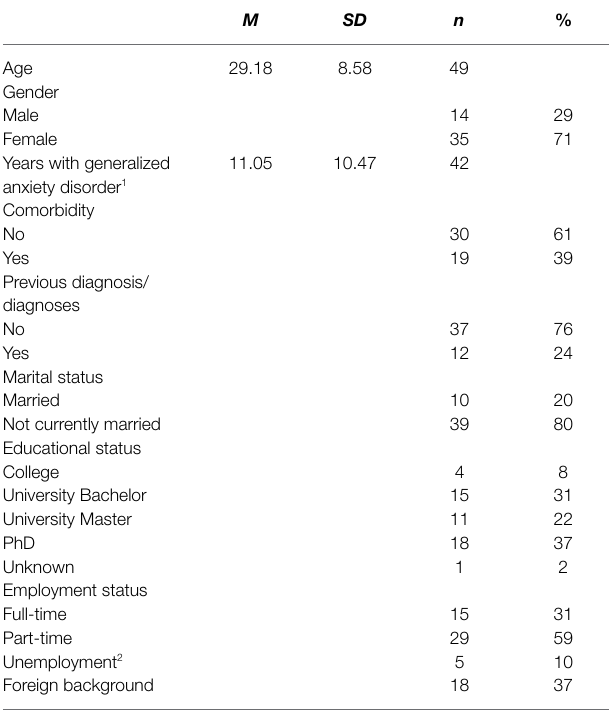
TABLE 1 | Demographic and clinical variables of the included